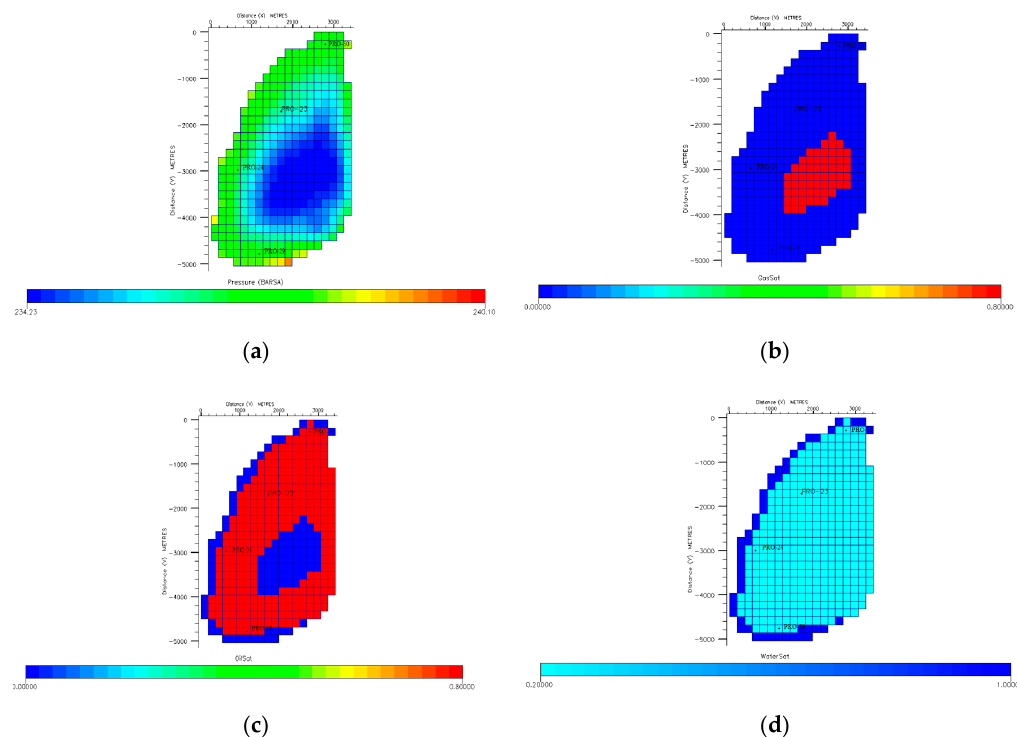
Figure 7. Description for case study 1 ( a – d ), ( a ) Initial pressure, ( b ) Initial gas saturation, ( c ) Initial oil saturation and ( d ) Initial water saturation.